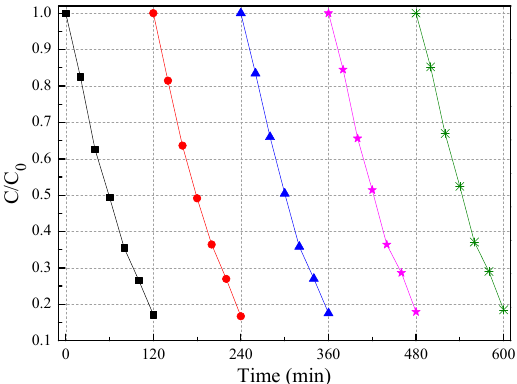
Figure 7. Effect of Ag content on the photocatalytic activity of CeO 2 @C-2 ( A ) and the effects of Cr(VI) concentration ( B ), pH value ( C ), and inorganic ions ( D ) on the photocatalytic activity of 3- Ag/CeO 2 @C-2.